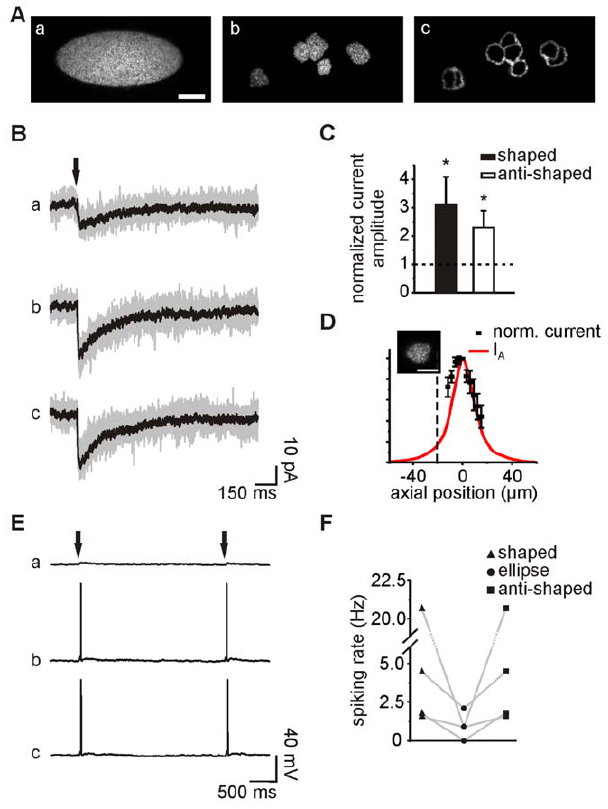
Figure 4. Electrophysiological recordings upon holographic photostimulation of multiple neurons. A. Images of three pattern configurations obtained by exciting a thin layer of fluorescein: ellipse (a), shaped (b) and anti-shaped (c) patterns. Scale bar: 20 m m. B. Photolysis-evoked currents elicited in a recorded CA1 neuron held at 2 60 mV by uncaging MNI-glutamate in a group of target cells with the three patterns in (A), using an energy of 3.5 m J at the sample plane. Individual sweeps (gray) and averaged currents (black) are shown (excitation densities: 0.9 nJ/ m m 2 , 3.6 nJ/ m m 2 and 10 nJ/ m m 2 for the elliptic, shaped and anti-shaped patterns, respectively). C. Histogram of current amplitude increases obtained with shaped and anti-shaped patterns normalized by the currents obtained with an ellipse. D. Mean normalized amplitudes of photolysis-evoked currents obtained in five recorded neurons held at 2 60 mV and excited with a shaped pattern, while changing the focal plane of the objective with steps of 3 m m. The top of the slice is indicated by the black dashed line. The theoretical axial distribution of light (I A ) for a shaped pattern is superimposed. Scale bar for the inset: 10 m m. E. Photolysis-evoked responses recorded in the same cell as in (B) in current-clamp mode. F. Comparison of spiking rates obtained with the three pattern configurations in four distinct cells.